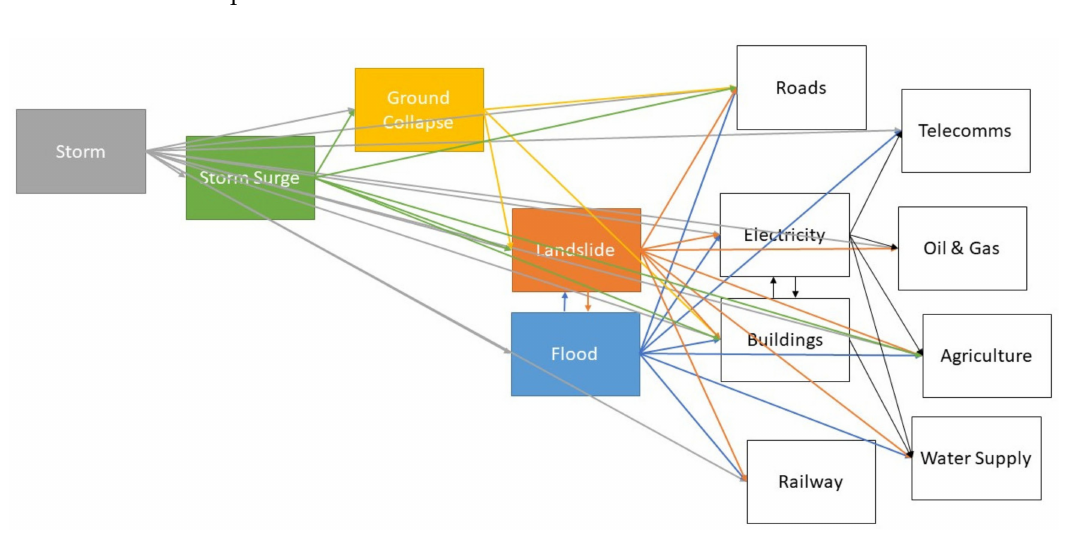
Figure 7. Network model framework summarizing literature review